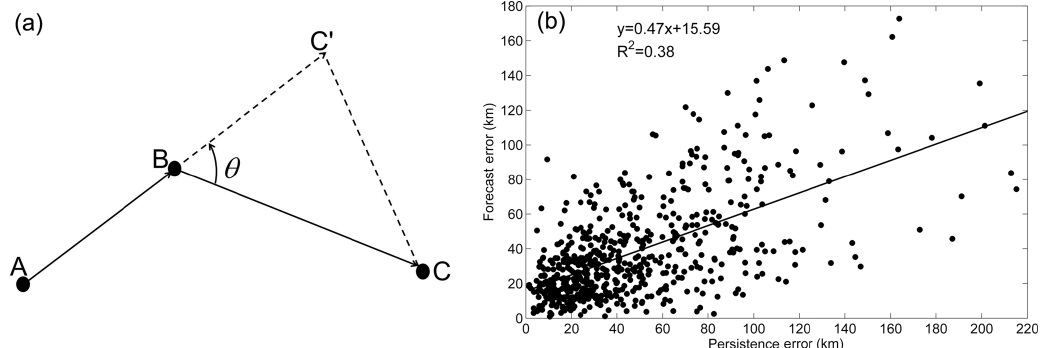
Figure 4. (a) Schematic of the persistence method. A, B, and C are three observed eddy positions on the trajectory at each 1-week interval. C’ is the predictive eddy position 1 week in advance by the persistence method; BC’ = AB. Thus CC’ is the persistence error at week